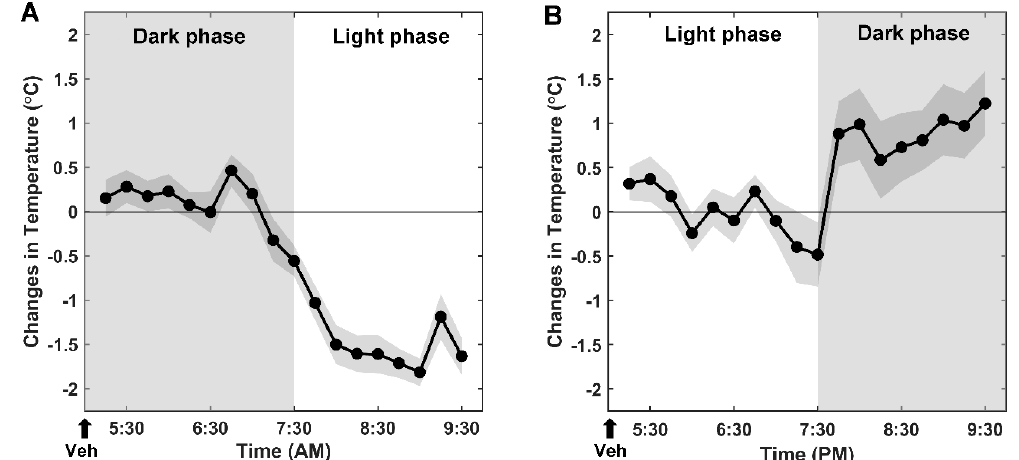
Figure 1. Body temperature (T b ) changes during the light–dark cycle in rats exposed to a 12/12-h light–dark cycle. ( A ) T b decreases during the transition from the dark phase to the light phase. ( B ) T b increases during the transition from the light phase to the dark phase. Lights on at 7:30 a.m. and off at 7:30 p.m. Data represent mean value ± SEM. Veh: s.c. injection of vehicle. 2.1. E ff ects of MLT Injected at the End of the Dark and of the Light Phases on T b